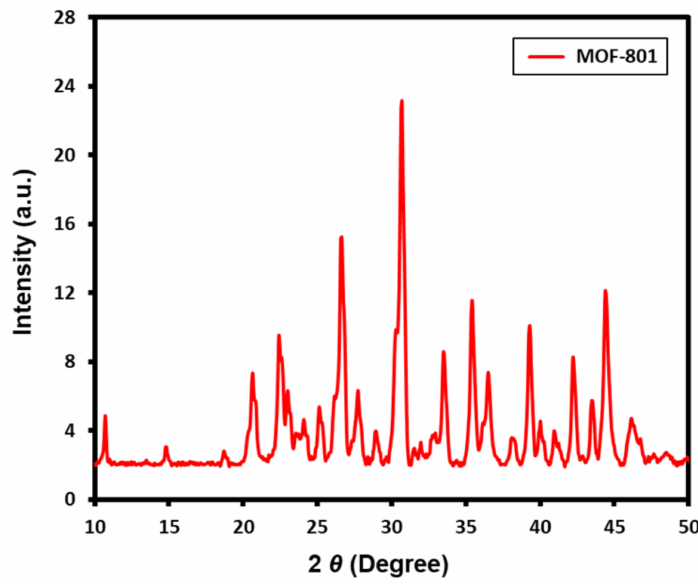
Figure 1. XRD analysis of